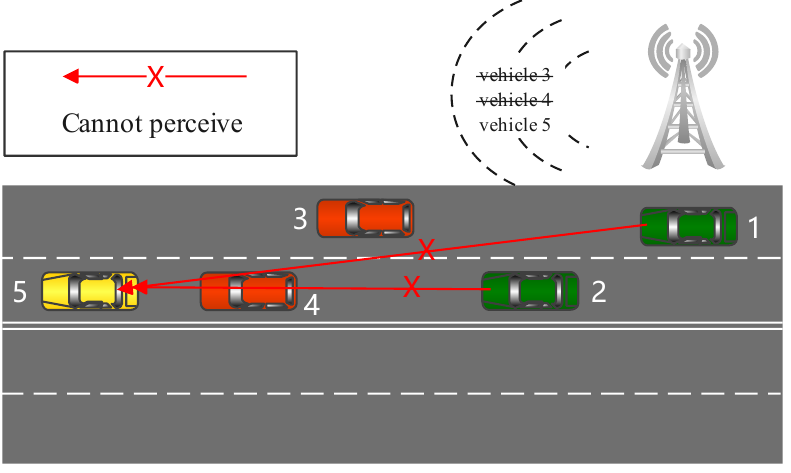
Figure 1. Scenario of broadcasting information